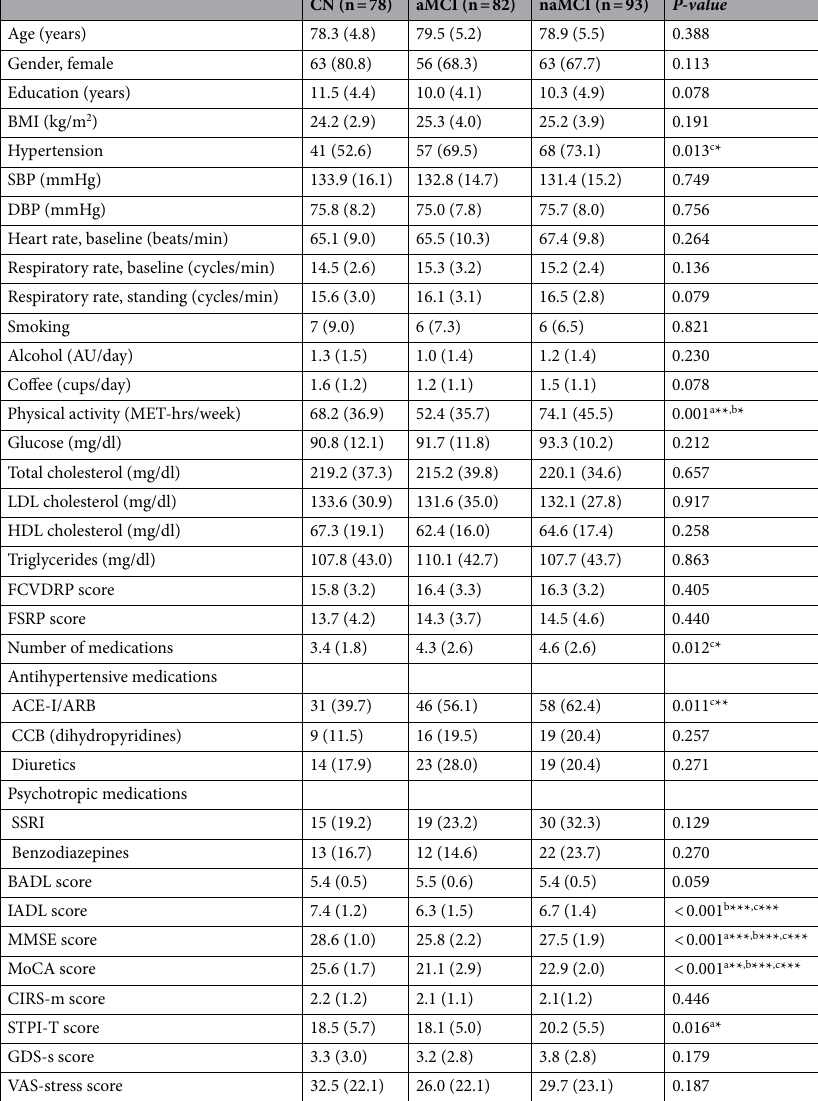
Table 1. Clinical characteristics of the study groups. Continuous variables expressed as mean (standard deviation), categorical variables expressed as n (%). ANOVA or Kruskall-Wallis test for continuous variables. Chi-squared or Fisher’s exact test for categorical variables. Pairwise comparisons with Bonferroni corrections. CN, cognitively normal (controls); aMCI, amnestic mild cognitive impairment; naMCI, non-amnestic mild cognitive impairment; BMI, body mass index; SBP, systolic blood pressure; DBP, diastolic blood pressure; AU, alcohol units (1 AU = 10 g of alcohol); MET, metabolic equivalent (energy expenditure index, 1 MET = 1 kcal∙kg −1 ∙h −1 ); LDL, low density lipoprotein; HDL, high density lipoprotein; FCVDRP, Framingham cardiovascular disease risk profile (score range − 6 to 38, higher scores indicate higher risk); FSRP, Framingham stroke risk profile (score range 0–48 , higher scores indicate higher risk); ACE-I, angiotensin converting enzyme inhibitors; ARB, angiotensin II receptor blockers; CCB, calcium channel blockers; SSRI, selective serotonin reuptake inhibitors; BADL, basic activities of daily living (score range 0–6, higher scores indicate greater functional independence); IADL, instrumental activities of daily living (score range 0–8, higher scores indicate greater functional independence); MMSE, mini mental state examination (score range 0–30, higher scores indicate better cognitive function); MoCA, Montreal cognitive assessment (score range 0–30, higher scores indicate better cognitive function); CIRS-m, cumulative illness rating scale morbidity (score range 0–13, higher scores indicate more severe comorbidity); STPI-T, state trait personality inventory- trait anxiety subscale (score range 10–40, higher scores indicate greater trait anxiety); GDS-s, geriatric depression scale short form (score range 0–15, higher scores indicate greater depressive symptoms); VAS, visual analogue scale (score range 0–100, higher scores indicate greater stress). a Significant difference between aMCI and naMCI, b Significant difference between aMCI and CN, c Significant difference between naMCI and CN, *** P ≤ 0.001, ** P < 0.01, * P <